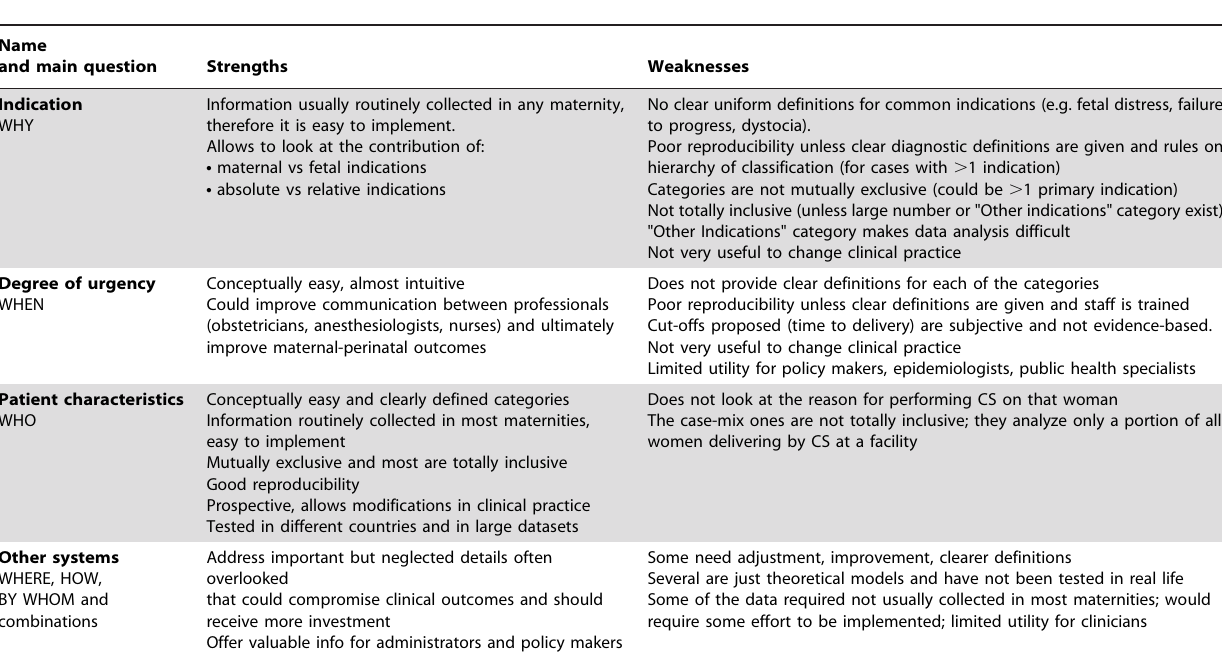
Table 3. Main types of Classification Systems for cesarean section: general strengths and